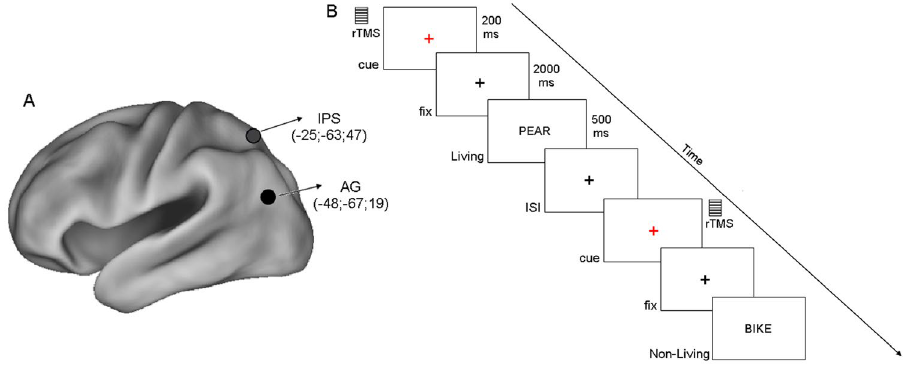
Figure 1. ( a ) Inflated view of left hemisphere atlas brain with the two regions stimulated in this experiment (AG and IPS) and relative coordinates as in meta-analysis of He et al . 36 and Wirth et al . 23 . ( b ) Example of the display sequence in the semantic memory task. Every 4 ± 0.5 sec a cue stimulus (a red small cross) was presented for 200 ms. The rTMS train (150 ms duration, 20-Hz frequency, and intensity set at 100% of the individual motor threshold) was delivered simultaneously to the cue onset. After 2 sec, a target word was presented for 500 ms at the centre of the screen and denoted a Living (50%) or a Non-Living (50%) entity. Subjects were instructed to maintain fixation on a central black cross, and to make a living/non-living judgment by pressing a corresponding button of the response box with their left/right index